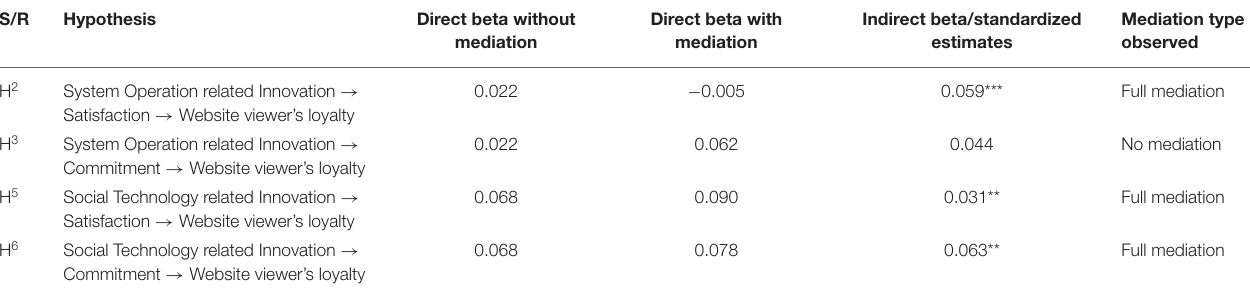
TABLE 7 | Results of in-direct effects in structural model.